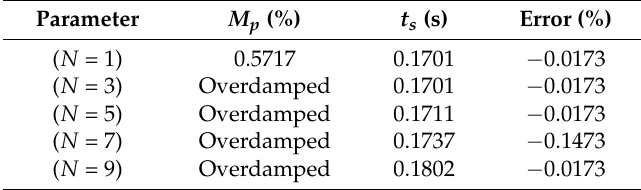
Table 5. Transient results obtained from the simulation in a closed loop with ZAD-FPIC.